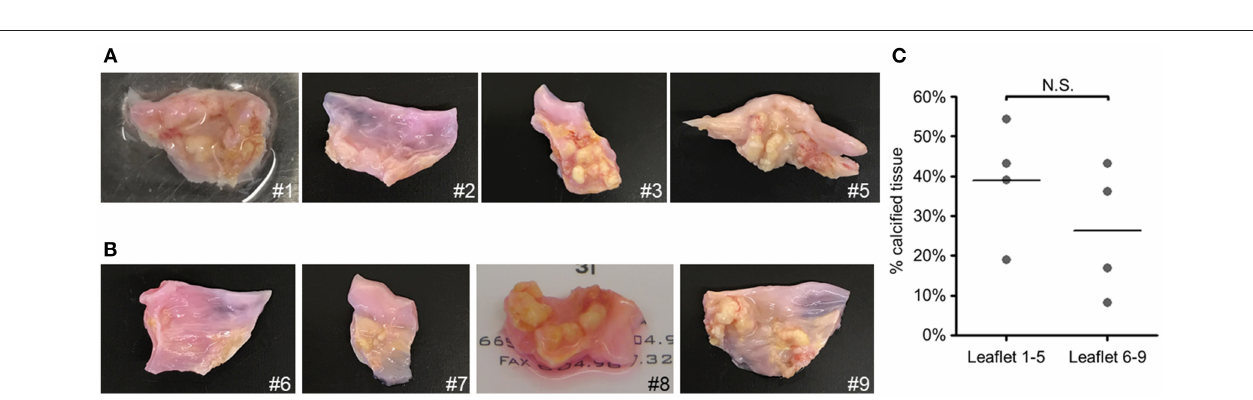
FIGURE 2 | Gross calcification of valve tissues from which calcification-prone VICs were isolated was not different from that in which calcification-resistant VICs were isolated. Images of aortic valve leaflets used to obtain VICs. Tissues from which calcification-resistant VICs were obtained, leaflets 1–5 shown in (A) , and calcification-prone VICs were obtained, leaflets 6–9 shown in (B) . Calcification-prone VICs were assessed to be Alizarin red-positive in passage one when cultured in OM, whereas calcification-resistant VICs did not calcify under these conditions. (C) Quantification of the percent-positive areas of calcified leaflets (indicated by